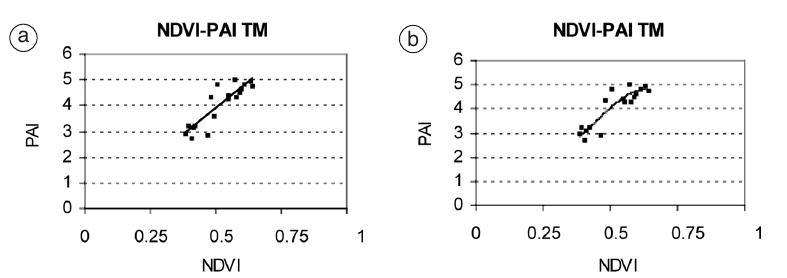
Fig. 3a,b. Linear (a) and cubic polynomial (b) relationships between NDVI values, calculated on the basis of the TM image, and PAI values measured in the field. The coefficient of determination ( R 2 ) equal to 0.79 for the linear relation ( y = 8.2782 x − 0.2459), and to 0.84 for the polynomial relation ( y =− 124.46 x 3 + 170.14 x 2 + − 66.787 x + 10.456).